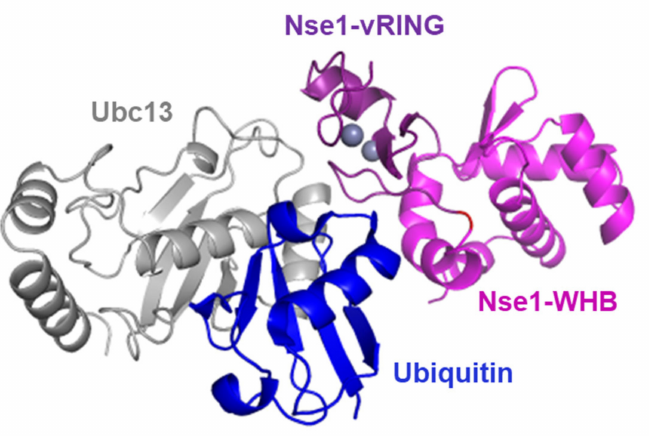
Figure 5. Model for Nse1–Ubc13~Ub complex. The Ubc13 E2 enzyme (grey) is charged with ubiquitin (blue) and binds the Nse1-vRING domain (dark violet). Ubiquitin is localized in the vicinity of the Nse1-WHB domain (light violet), and their interaction may enhance the ubiquitination